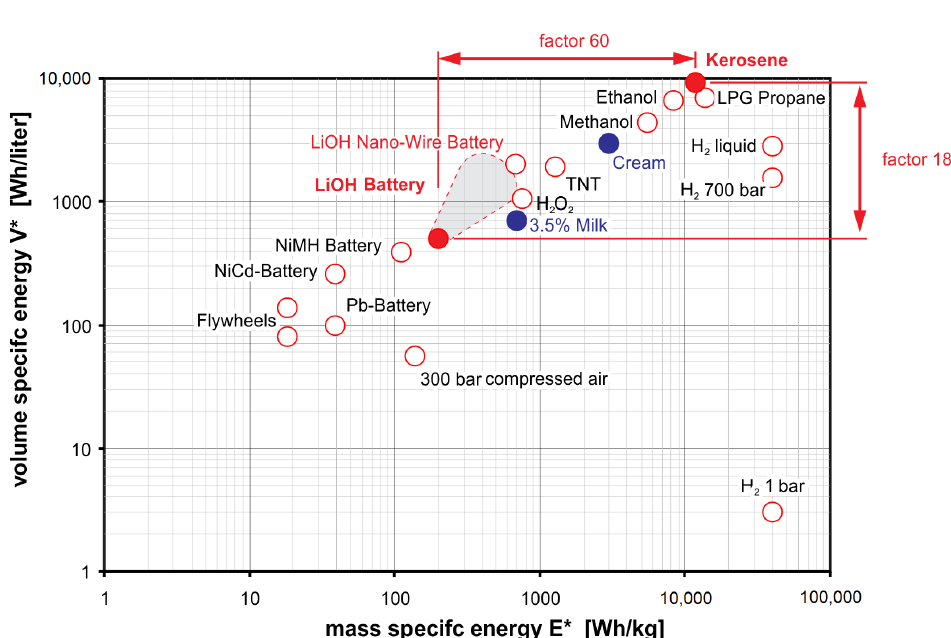
Figure 6. Volume and mass-specific energy characteristics of different types of energy sources [34]. Credits: NATO.